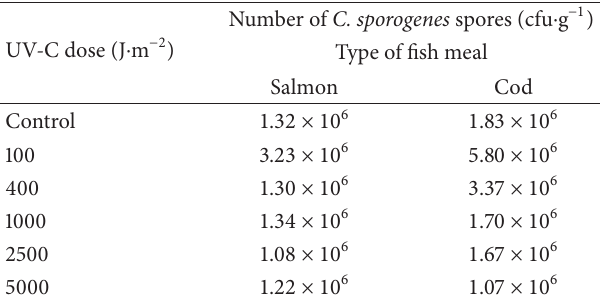
Table 5: Changes in the number of Clostridium sporogenes spores depending on the surface density of the UV-C radiation dose.